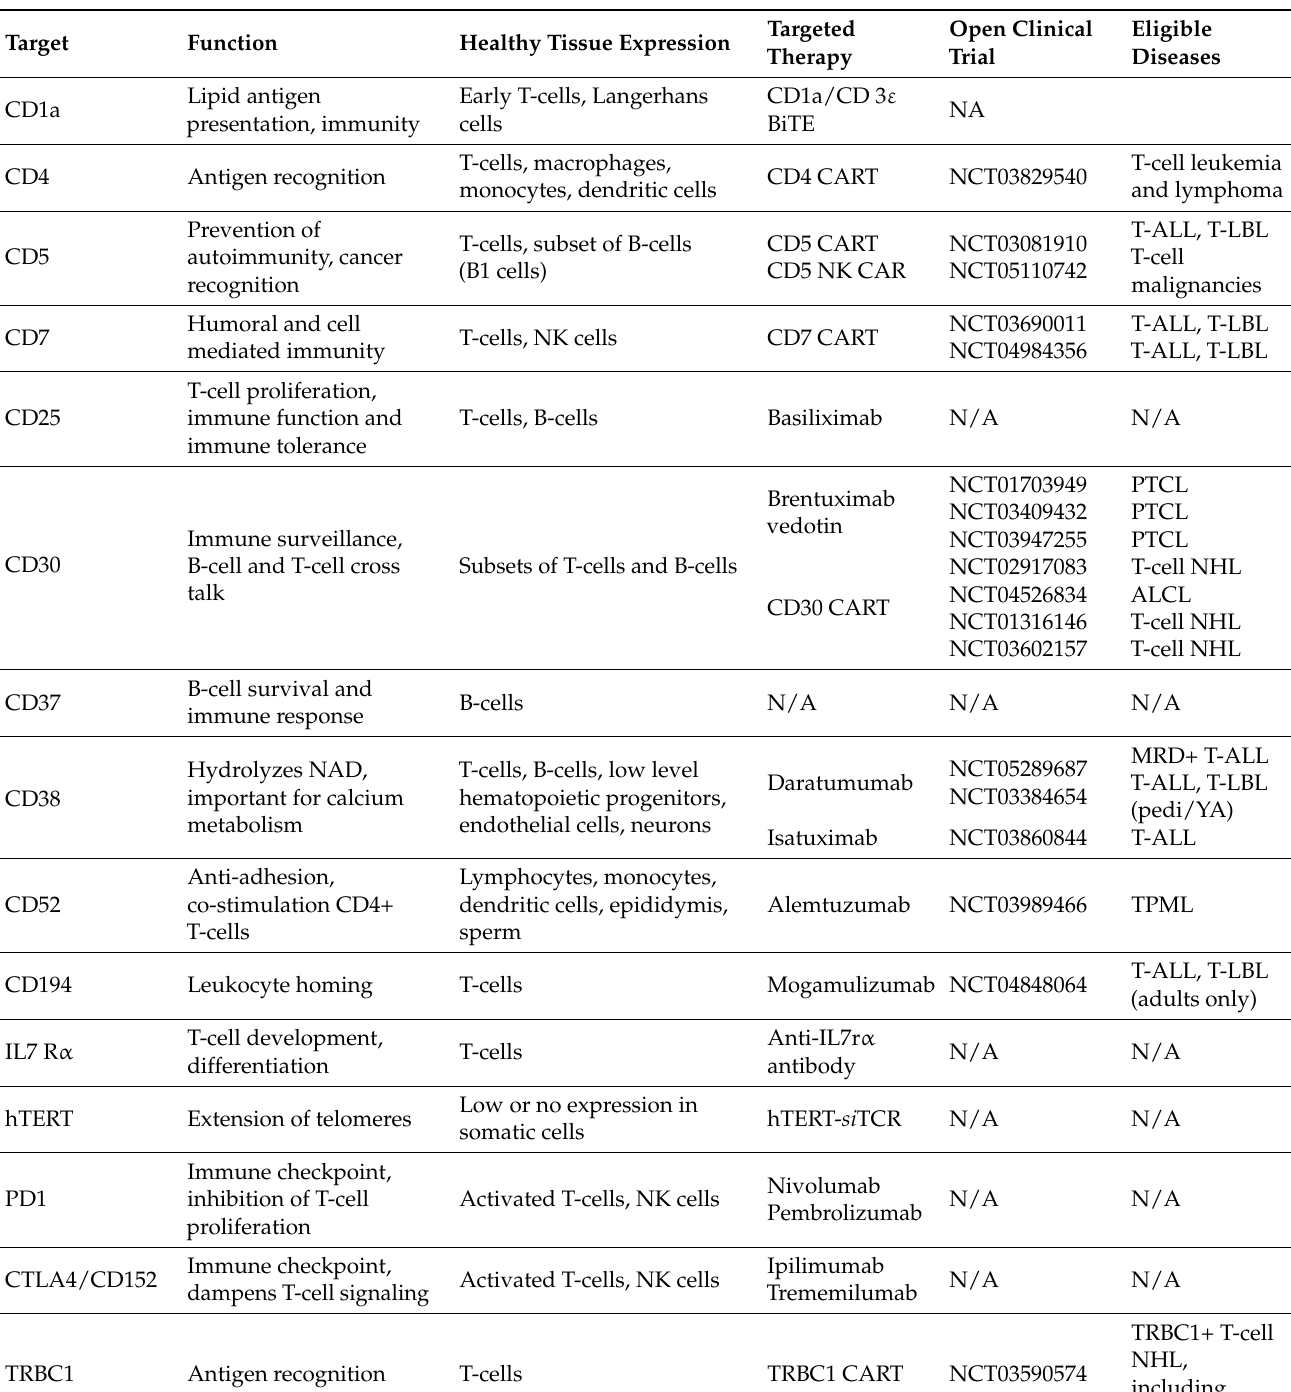
Table 1. Target antigen function, expression, therapies, open clinical trials and